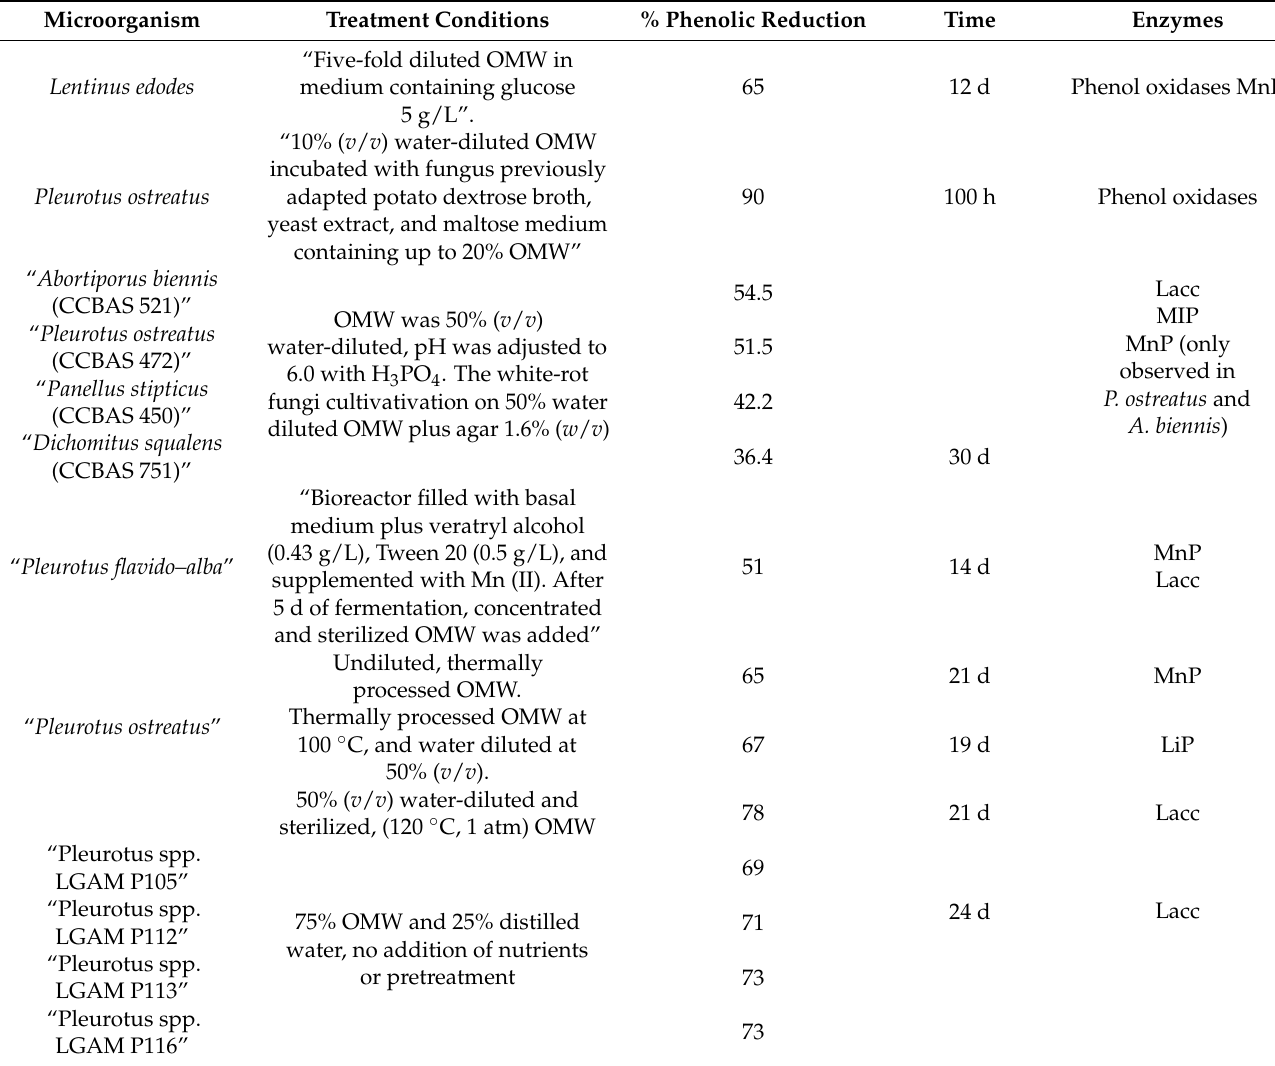
Table 7. Enzymes produced by ligninolytic fungi during OMW biological treatment of OMW [8]. Microorganism Treatment Conditions % Phenolic Reduction Time